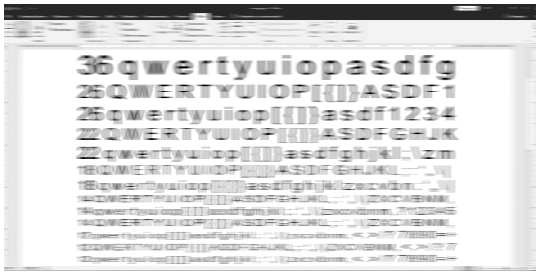
Figure 6. Image reconstructed by summing 30 images for the line length 𝑑 = 1920.001